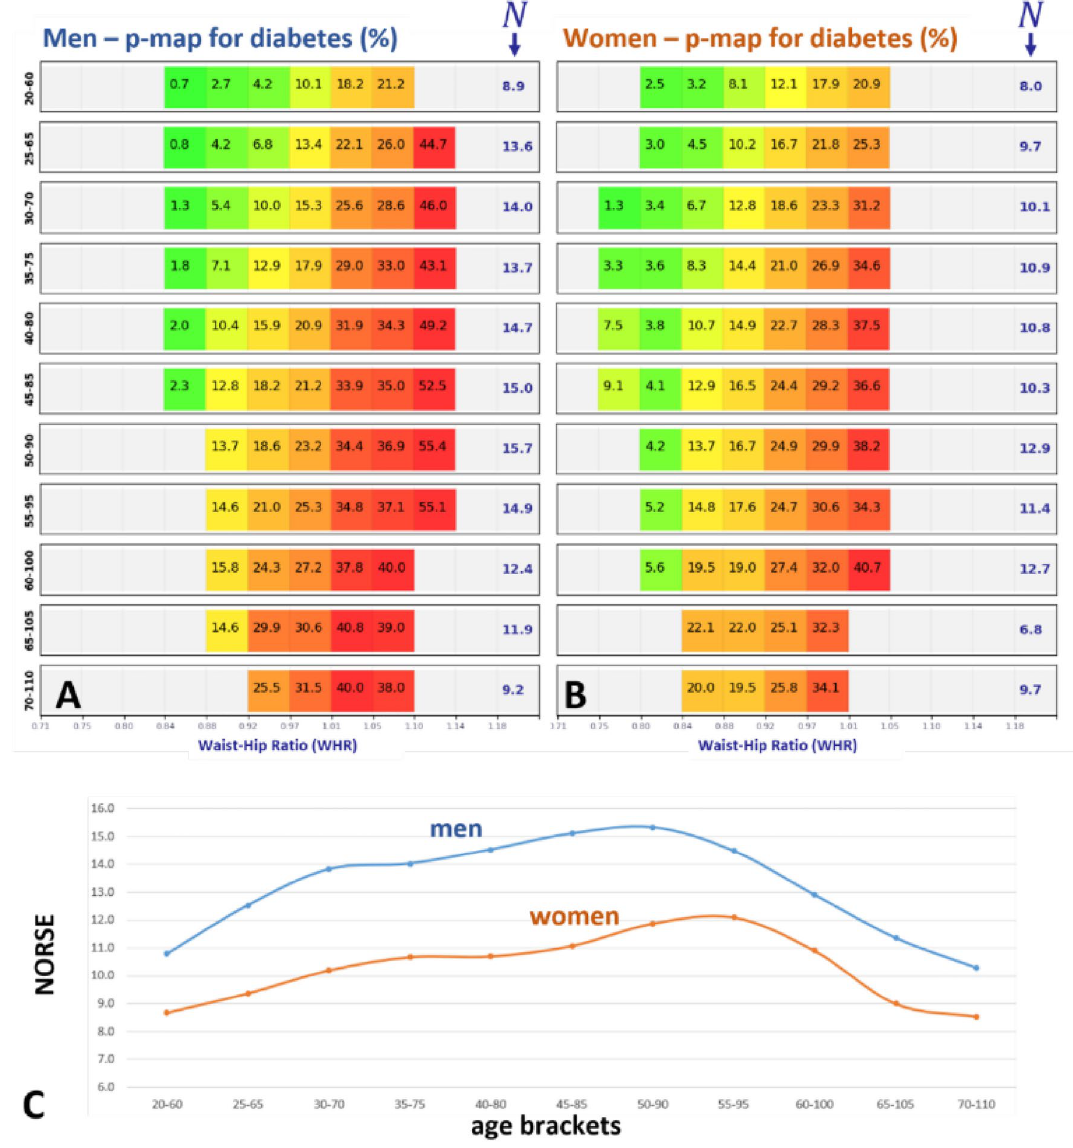
Figure 2. Age stratification of NORSE for C = diabetes in adult men ( A ) and women ( B ). ( C ) NORSE curve as a function of